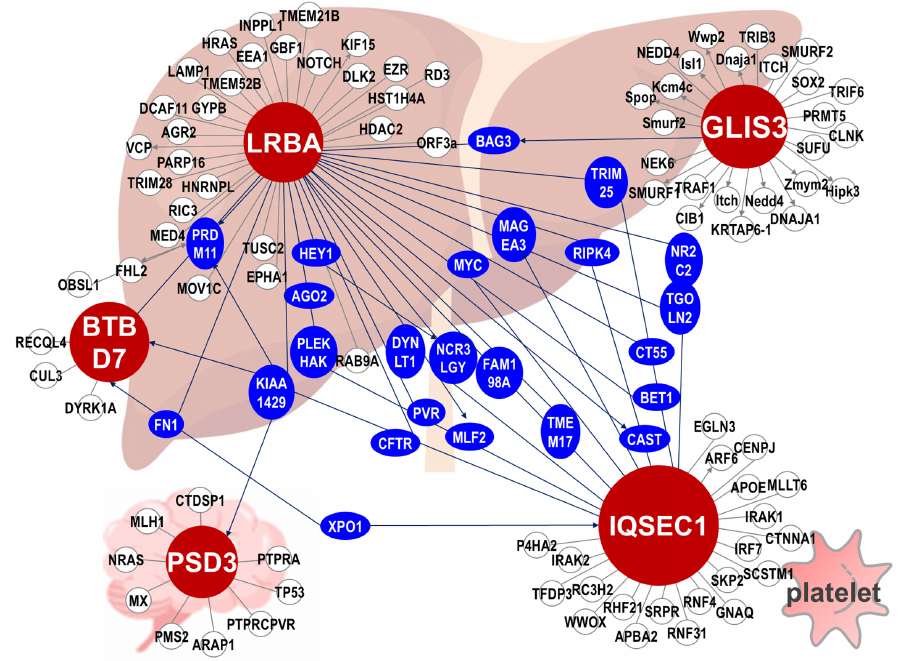
Figure 5. Protein–protein interaction network of the SNPs identified by AI-assisted analysis using SNP datasets obtained from patients of clopidogrel-resistant patients. The protein–protein interaction network was established by SNP within the protein coding genes. The red dots indicate the genes of AI-assisted SNP, and the blue dots indicate the proteins that connect the proteins in which the SNPs are located in the network. LRBA, LPS Responsive Beige-Like Anchor Protein. The figure is created with BioRender.com.